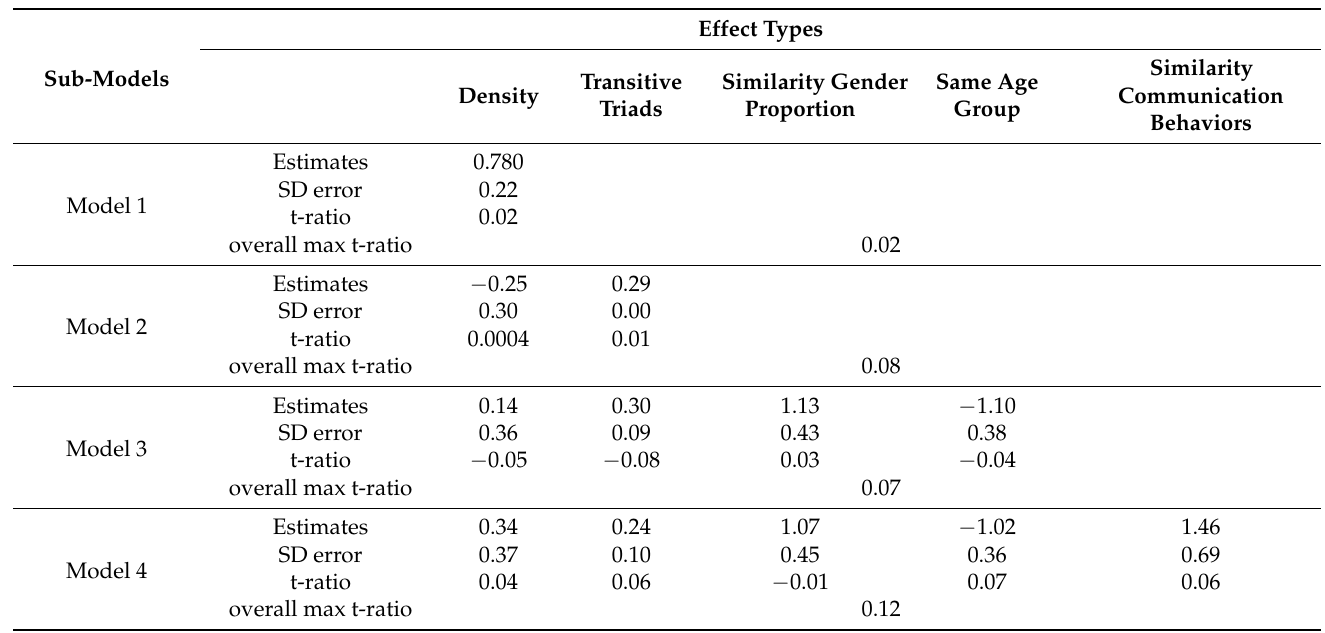
Table 4. The results of